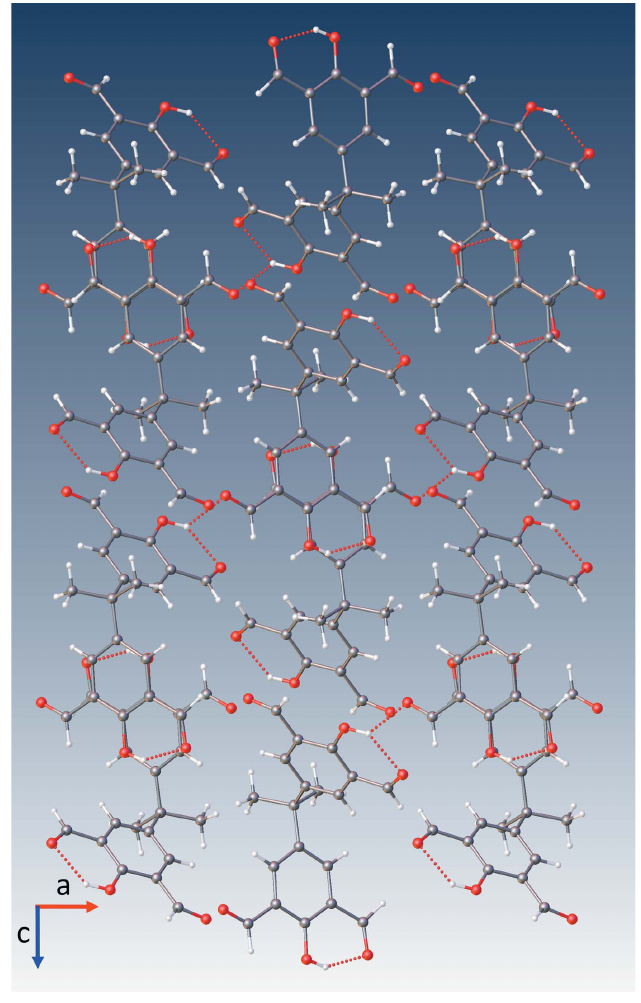
Figure 5 Crystal packing of ( 2 ) viewed along the b axis showing both the intra- and intermolecular hydrogen bonds (red dashed